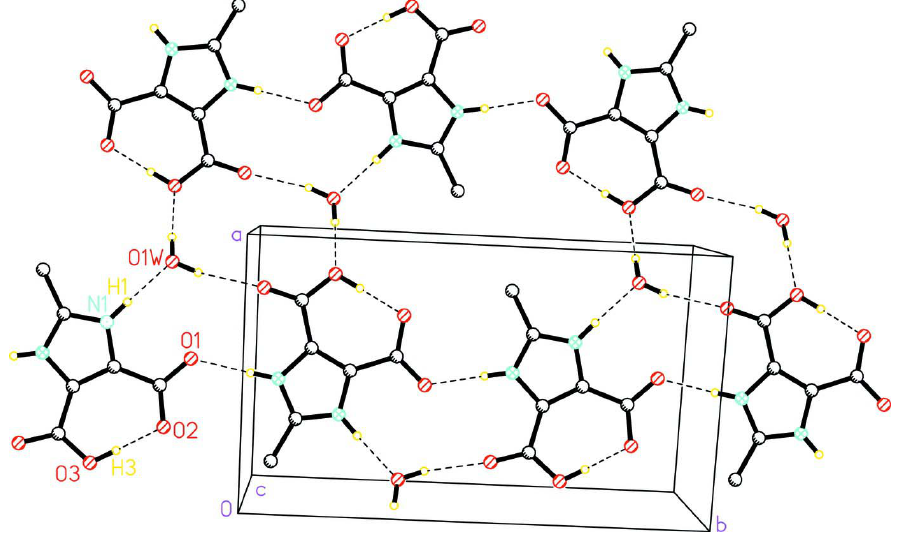
Figure 2 Packing diagram of the title structure, showing the intermolecular N—H···O and O—H···O hydrogen bonds as dashed lines. Methyl H atoms are omitted for